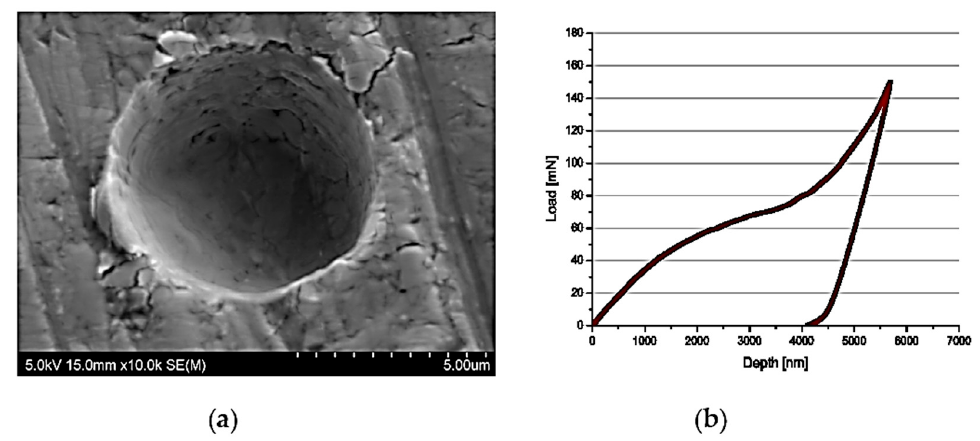
Figure 4. Image of: ( a ) the surface of the sample after preliminary push out tests ( b ) typical curve load–displacement.